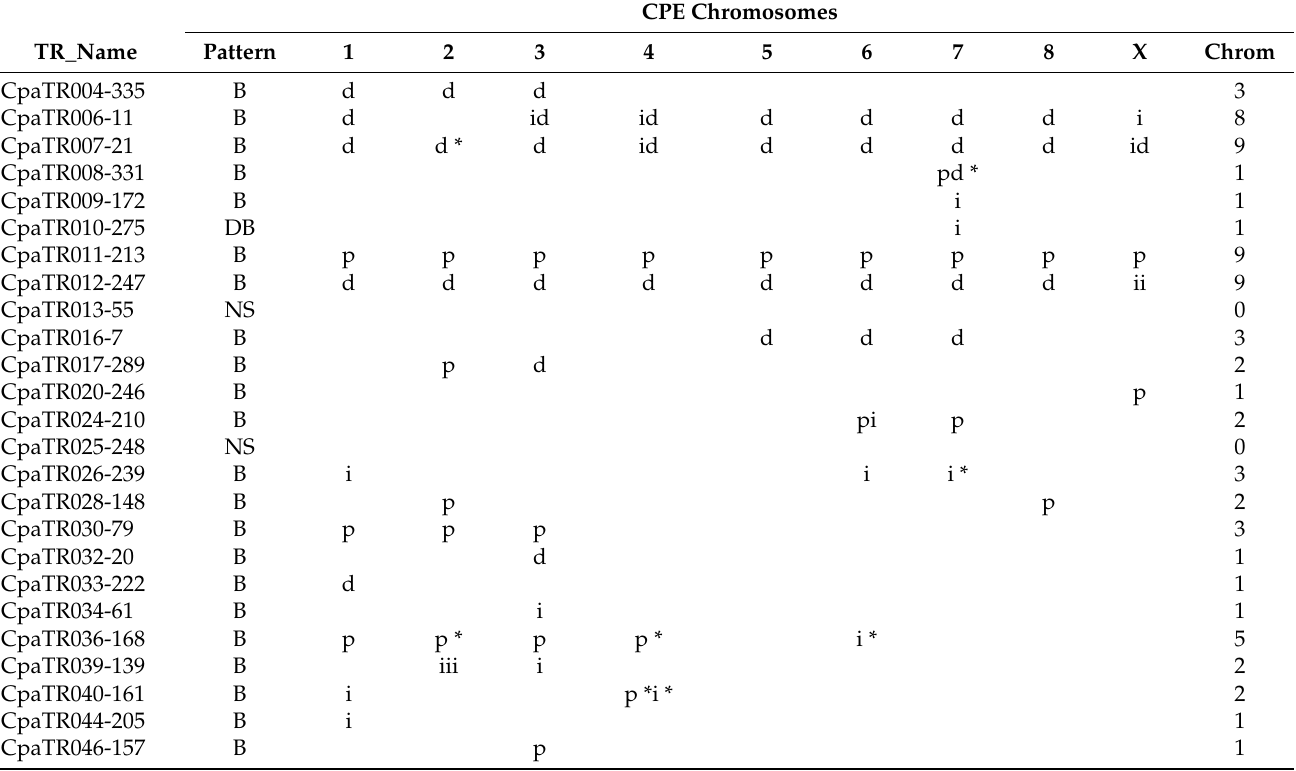
Table 3. Chromosome location of 50 TR families in the CPE subspecies of C. parallelus . Asterisks (*) indicate that bands were observed on only one member of a chromosomal pair. Chromosome location (pattern) could be pericentromeric (p), interstitial (i), or distal (d). B = banded, DB = dotted- banded, NS = no signal, Chrom = number of chromosomes displaying bands for a given TR family. CPE = Chorthippus parallelus erythropus . CPE Chromosomes